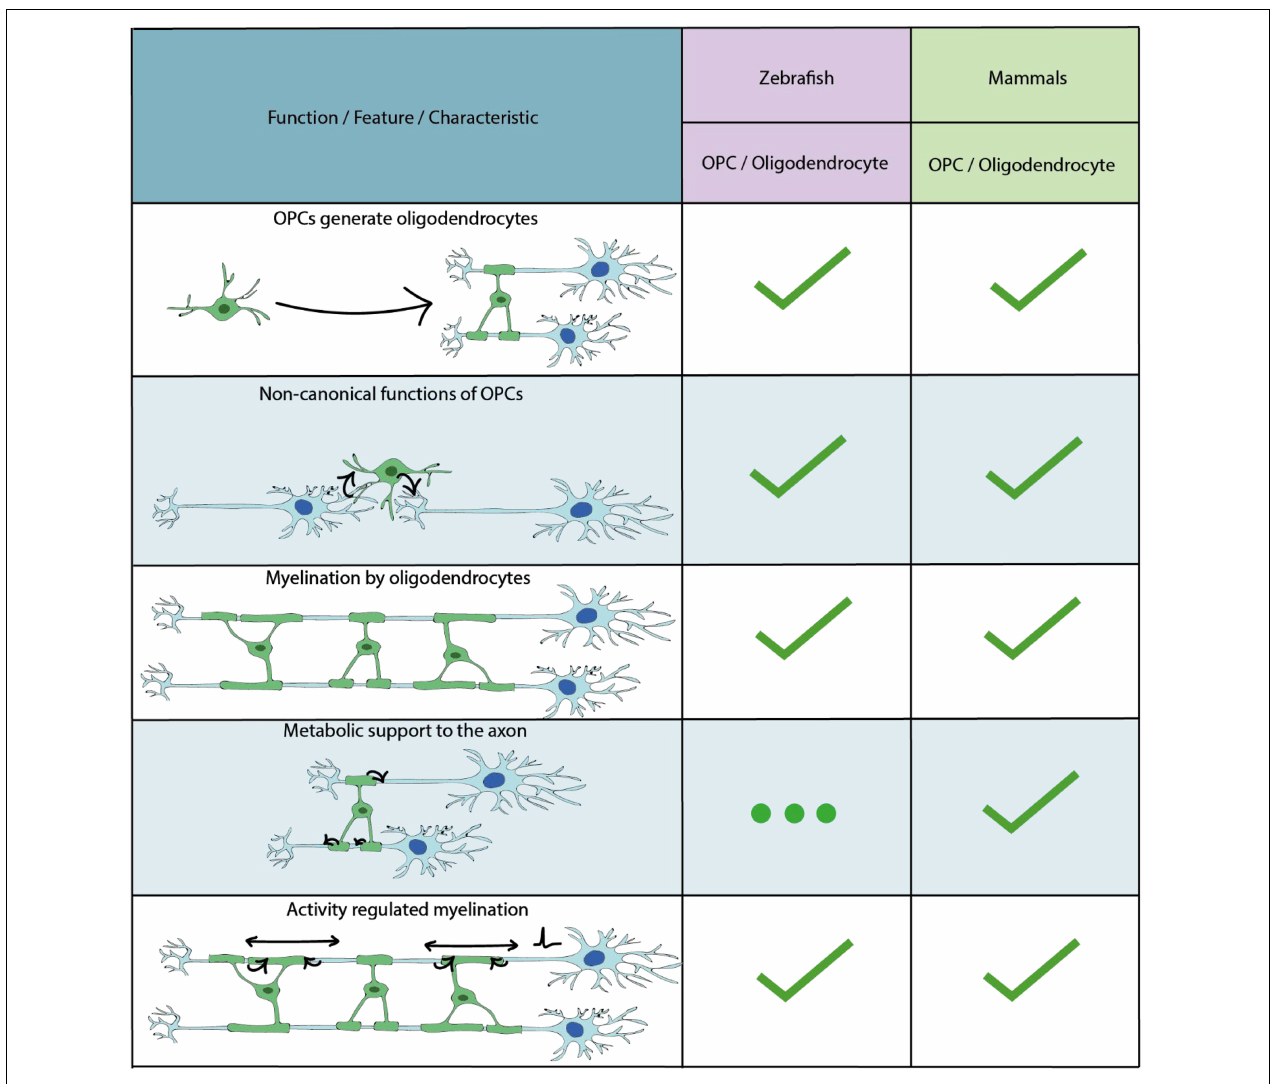
FIGURE 3 | Key characteristics and functional properties of zebrafish and mammalian OPCs and oligodendrocytes. The use of “ ... ” refers to areas of OPC/oligodendrocyte biology which require further